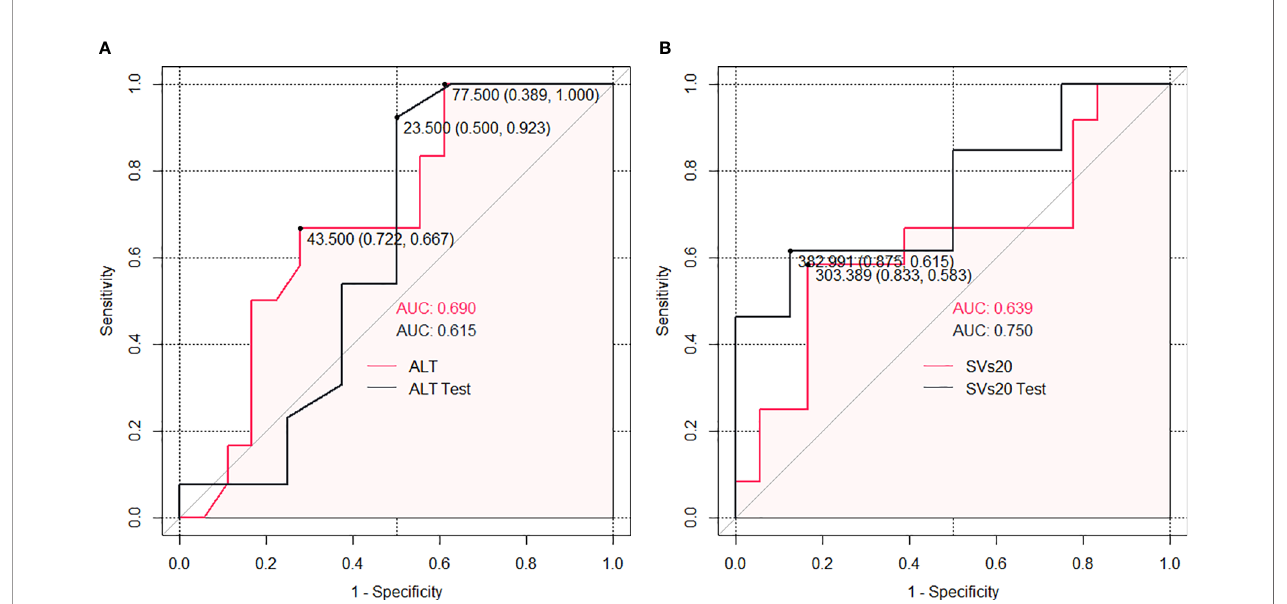
FIGURE 3 | The cut-off points and AUC of each optimal predictors by ROC analysis: (A) ALT; (B) SVs20.